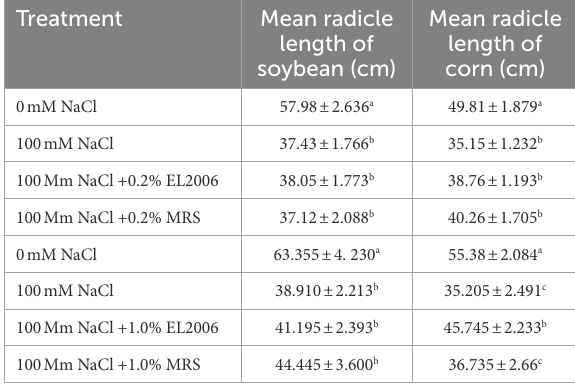
Data represents the mean ± SE ( n = 80); in a column, different letters indicate values determined by Tukey’s multiple mean comparison significantly different at p < 0.05. Values with the same letters are not significantly different at p <